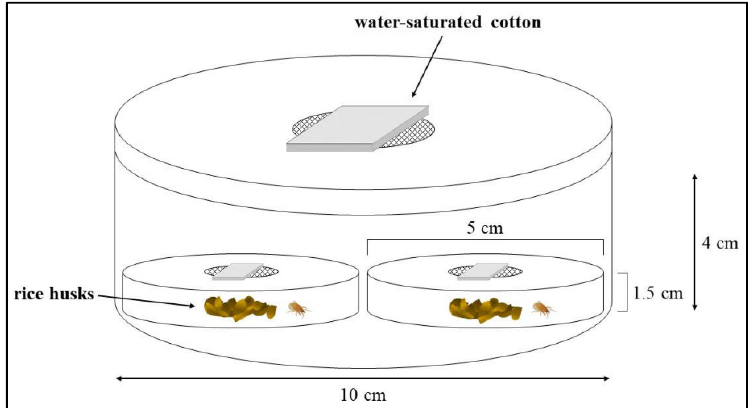
Figure 1. Experimental setup for the life table study of the two predatory mite species under laboratory conditions.